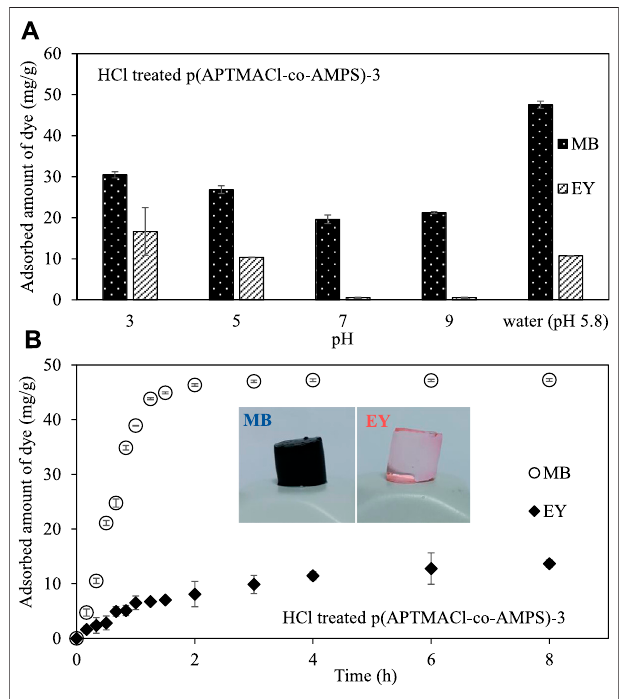
FIGURE 5 | (A) The effect of pH on adsorption of MB and EY by HCl- treated p (APTMACl-co-AMPS)-3 hydrogels, and (B) the adsorbed amount of MB and EY by HCl-treated p (APTMACl-co-AMPS)-3 hydrogels with time. (Adsorption conditions: 50 mg hydrogel, 50 ml 50 ppm MB and EY solutions, 500 rpm stirring rate, room